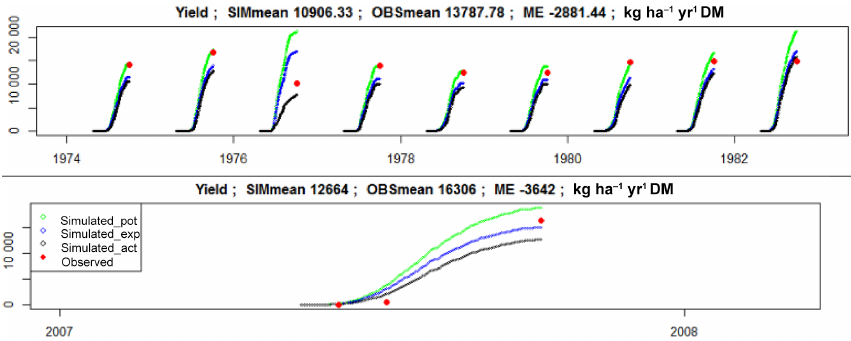
Figure 6. Results of simulated and observed yields of silage maize: Cranendonck 16 (upper panel) and Dijkgraaf (lower panel). The green lines correspond with the simulated potential yield; blue with the simulated exploitable yield; black with the simulated actual yield; red dots indicate the observed dry matter yield. SIMmean, OBSmean and ME are annual mean values for simulated actual yield, observed yield and the difference (maximum error